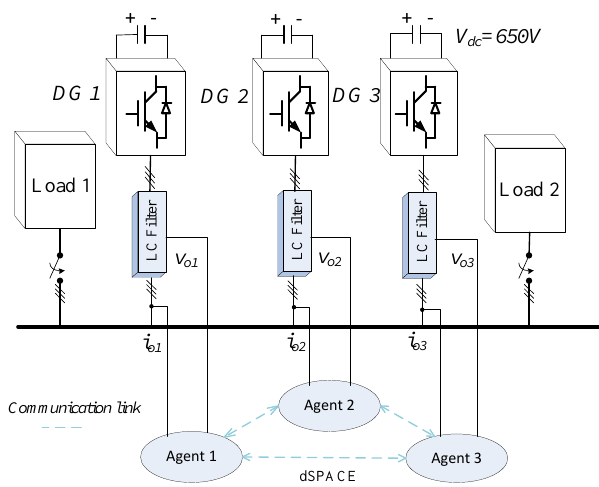
Figure 12. Experimental configuration.